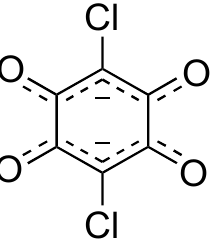
Table 2. Summary of SHAPE parameters 1 for lanthanide centers in the series of the dinuclear complexes 1 – 5 .